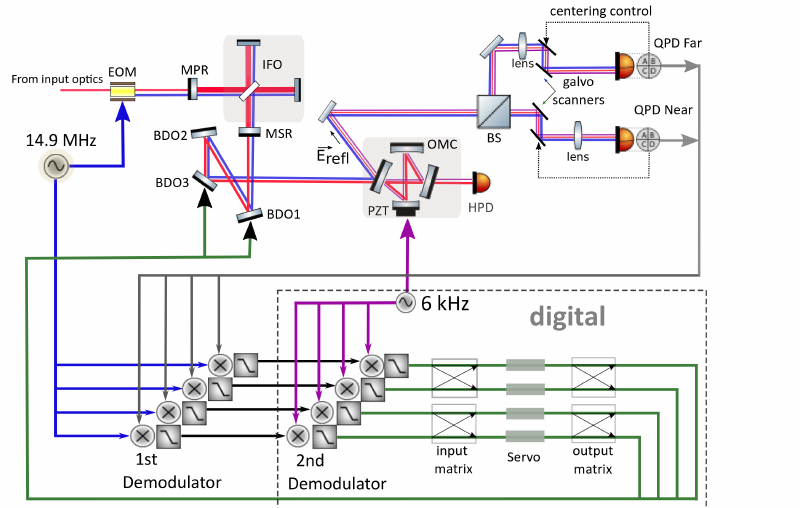
Figure 2. Schematic of the Modulated differential wavefront sensing (MDWS) sensing and control scheme. The input optics have been ignored for simplicity. The Michelson interferometer (MI) sidebands (SBs), f MI , at 14.9MHz are imprinted onto the carrier via the EOM before it enters the IFO. The OMC length modulation, f OMC , at 6kHz marks the eigen mode of the OMC and is applied through the digital control system. The QPD signals are demodulated twice as shown to give the MDWS error signal which is used for actuation on the BDO1 and BDO3